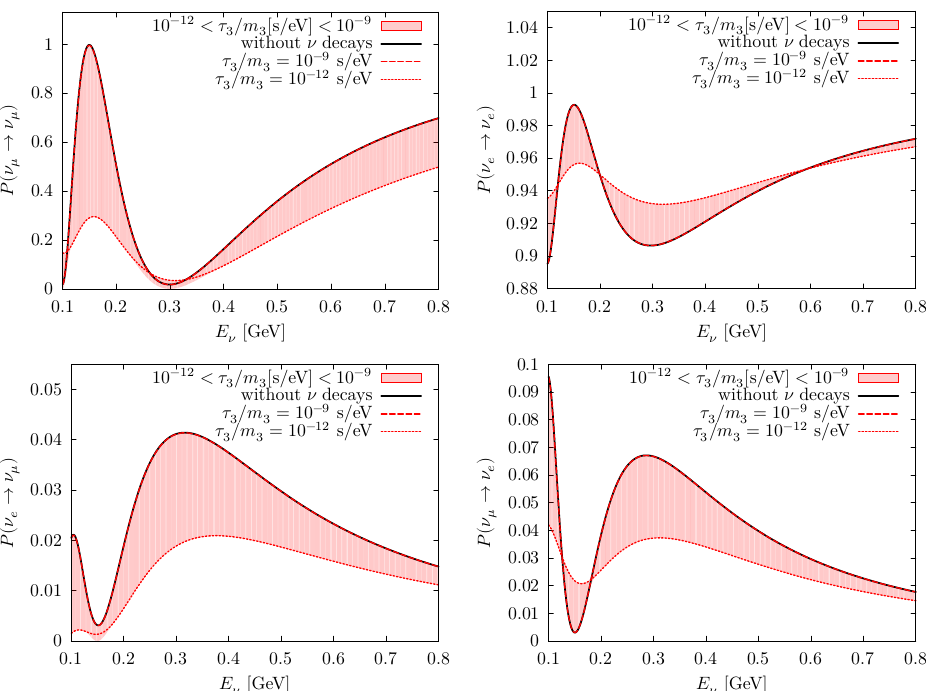
Figure 1 . The oscillation probabilities within 10 (cid:0) 12 s/eV < (cid:28) 3 =m 3 < 10 (cid:0) 9 s/eV (red band) for MOMENT. We especially present the probability with (cid:28) 3 =m 3 = 10 (cid:0) 12 s/eV (red-dotted curve), = 10 (cid:0) 9 s/eV (red-dashed curve) and = 1 (black curve). Four channels are shown: (cid:23) (cid:22) ! (cid:23) (cid:22) (upper-left), (cid:23) e ! (cid:23) e (upper-right), (cid:23) e ! (cid:23) (cid:22) (right-left), and (cid:23) (cid:22) ! (cid:23) e (lower-right). The following oscillation parameters are used: (cid:18) 12 =33 : 8 (cid:14) , (cid:18) 13 = 8 : 61 (cid:14) , (cid:18) 23 = 49 : 6 (cid:14) , (cid:1) m 2 (cid:1) m 2 = 2 : 52 (cid:2) 10 (cid:0) 3 eV 2 , and (cid:14) = 270 (cid:14) . 31 P ( (cid:23) ! (cid:23) ) (cid:24) P ((cid:22) (cid:23) ! (cid:22) (cid:23) ). Based on the size of variations, we reach the conclusion that e (cid:22) (cid:22) e the (cid:22) -(cid:13)avour disappearance channel is the more important than the other channels in the measurement of (cid:28) =m 3 3